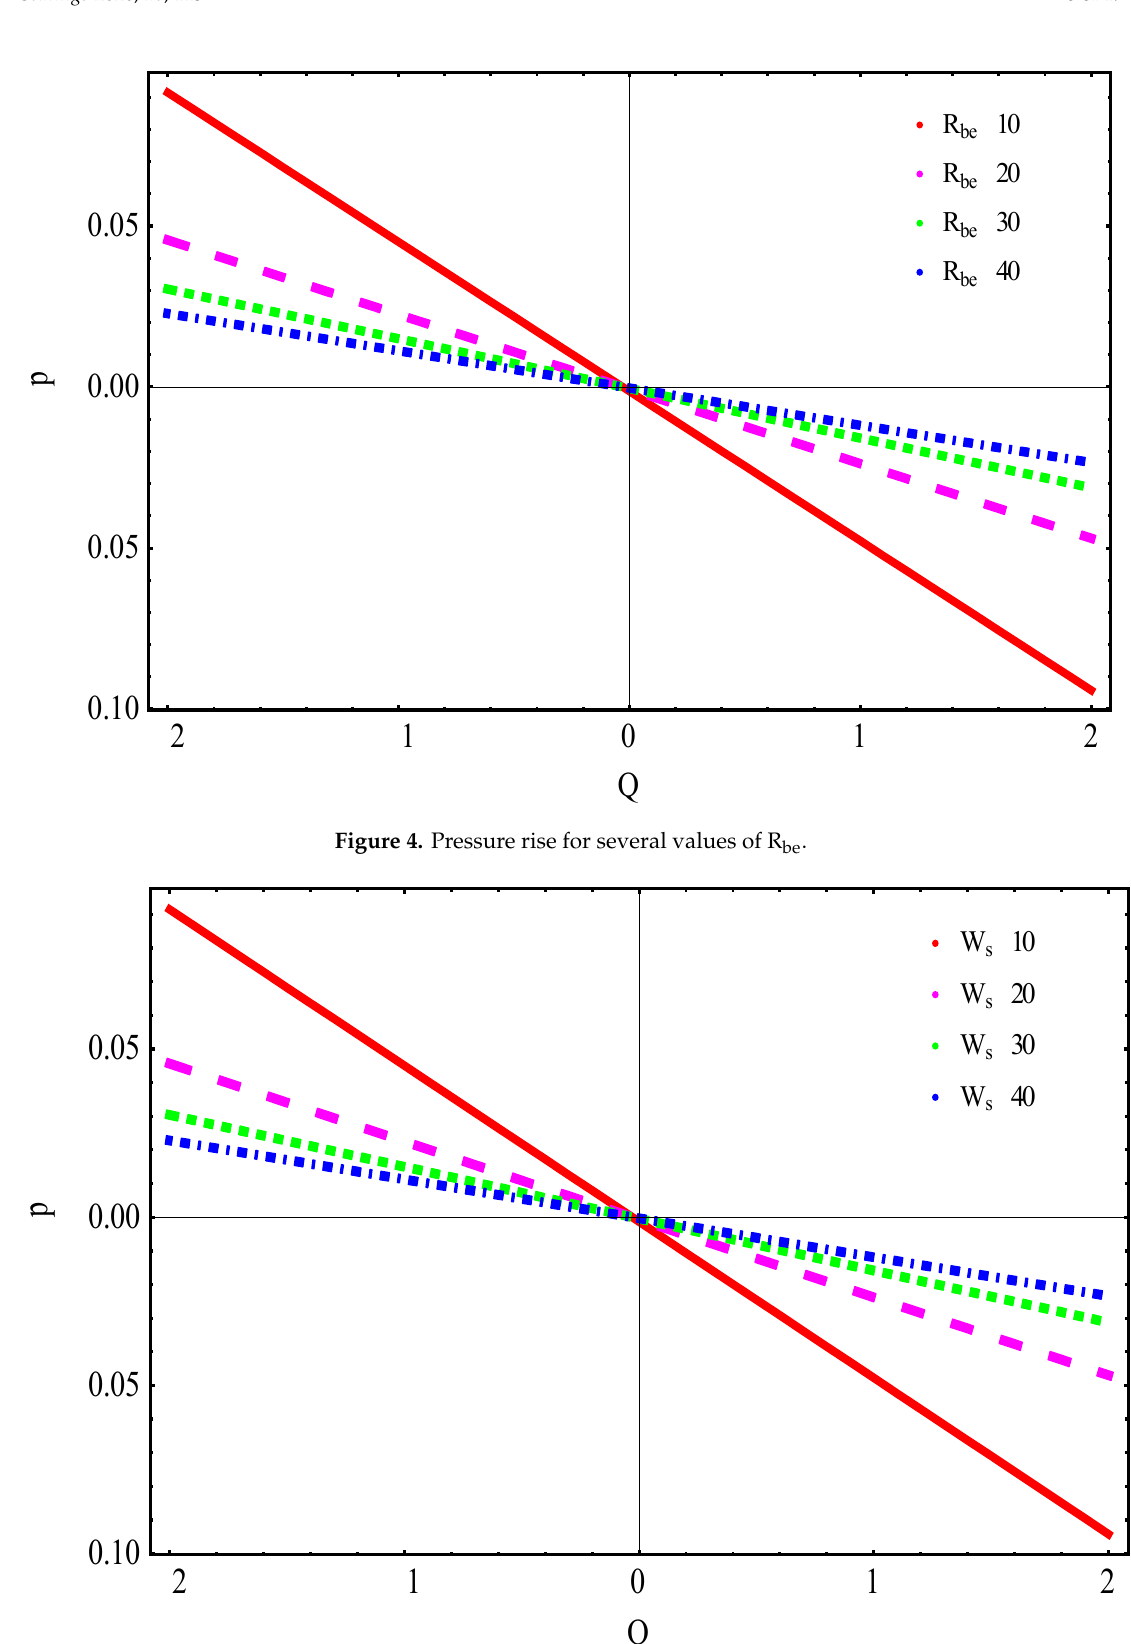
Figure 5. Pressure rise for several values of 𝑊 (cid:3046) .